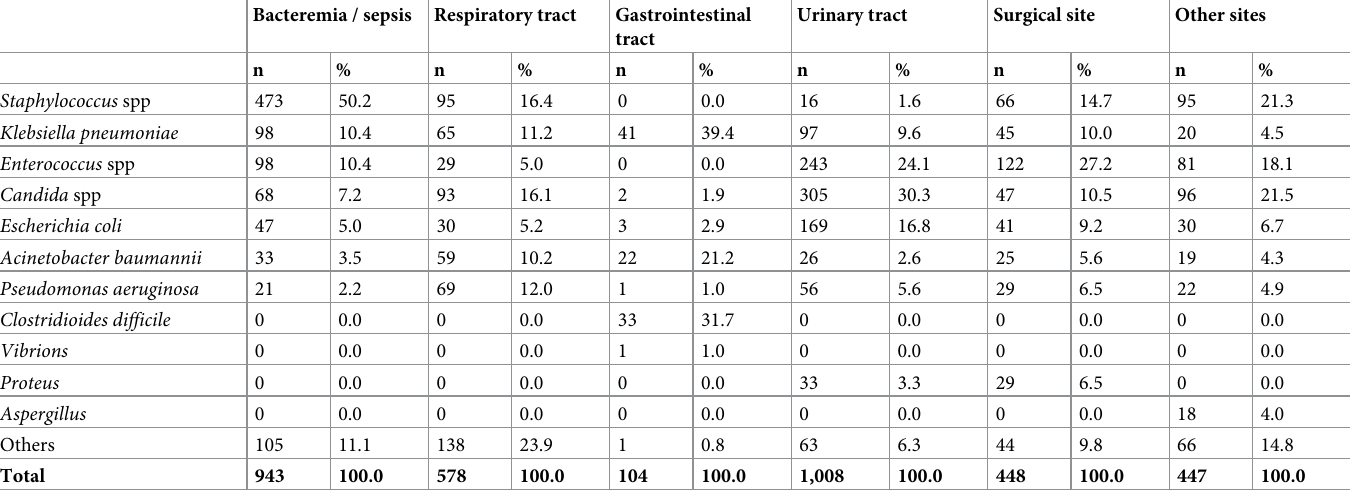
Table 4. Frequency of alert microorganisms over the site of